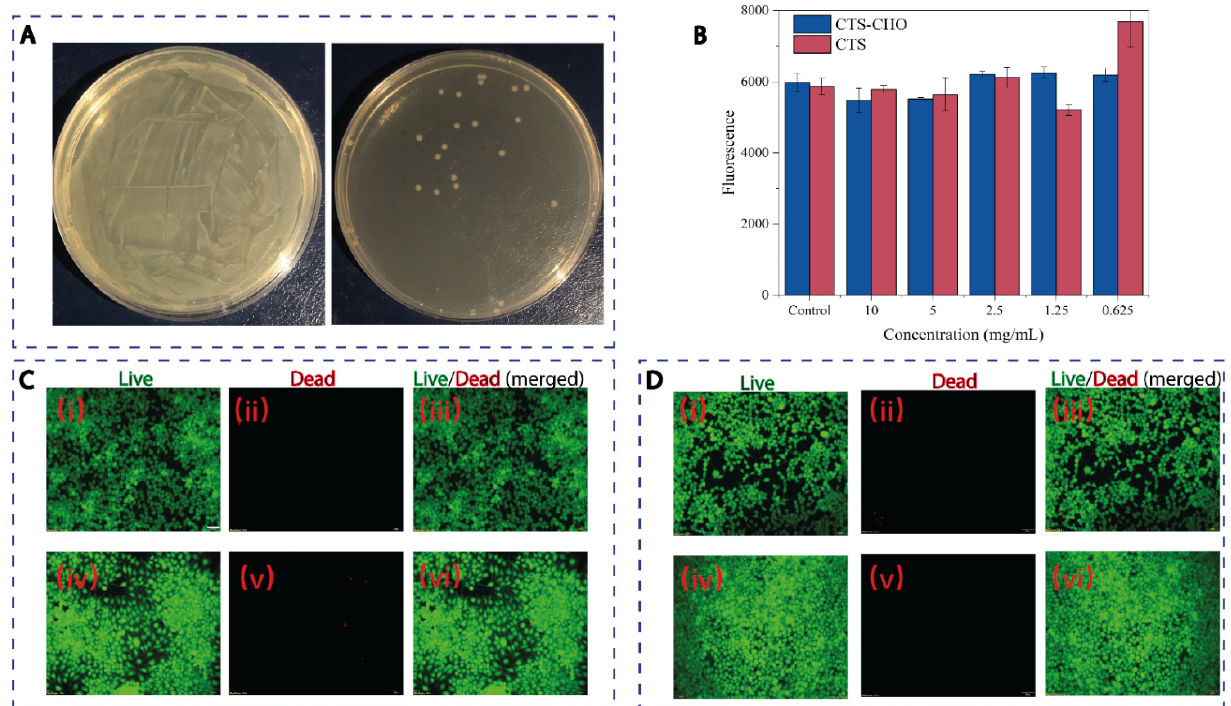
Figure 4. ( A ) Antibacterial properties of CTS/CTS–CHO hydrogels against E. coli : (i) Control; (ii) CTS/CTS–CHO hydrogel. ( B ) AlamarBlue measurements of CTS and CTS–CHO co-cultured with HEK 293 cells for 1 day ( n = 3). ( C ) Live/Dead staining of HEK 293 cells cultured with the extract of CTS/CTS–CHO hydrogels for 24 h: (i)–(iii) Control; (iv)–(vi) CTS/CTS–CHO hydrogels. ( D ) Live/Dead staining of HEK 293 cells cultured with the extract of CTS/CTS–CHO hydrogels for 48 h: (i)–(iii) Control; (iv)–(vi) CTS/CTS–CHO hydrogels. Scale bar: 50 μ m.